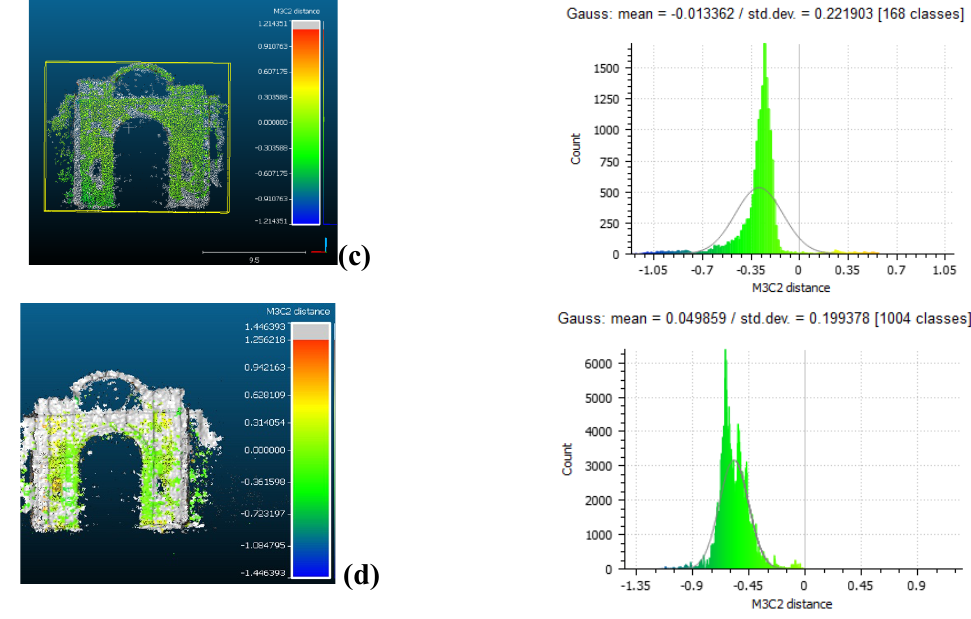
Figure 15. CloudCompare M3C2 distances processed between 3DF Zephyr and: Agisoft Metashape (a), Regard3D (b), VisualSfM (c) and Meshroom (d), with the corresponding Gaussian